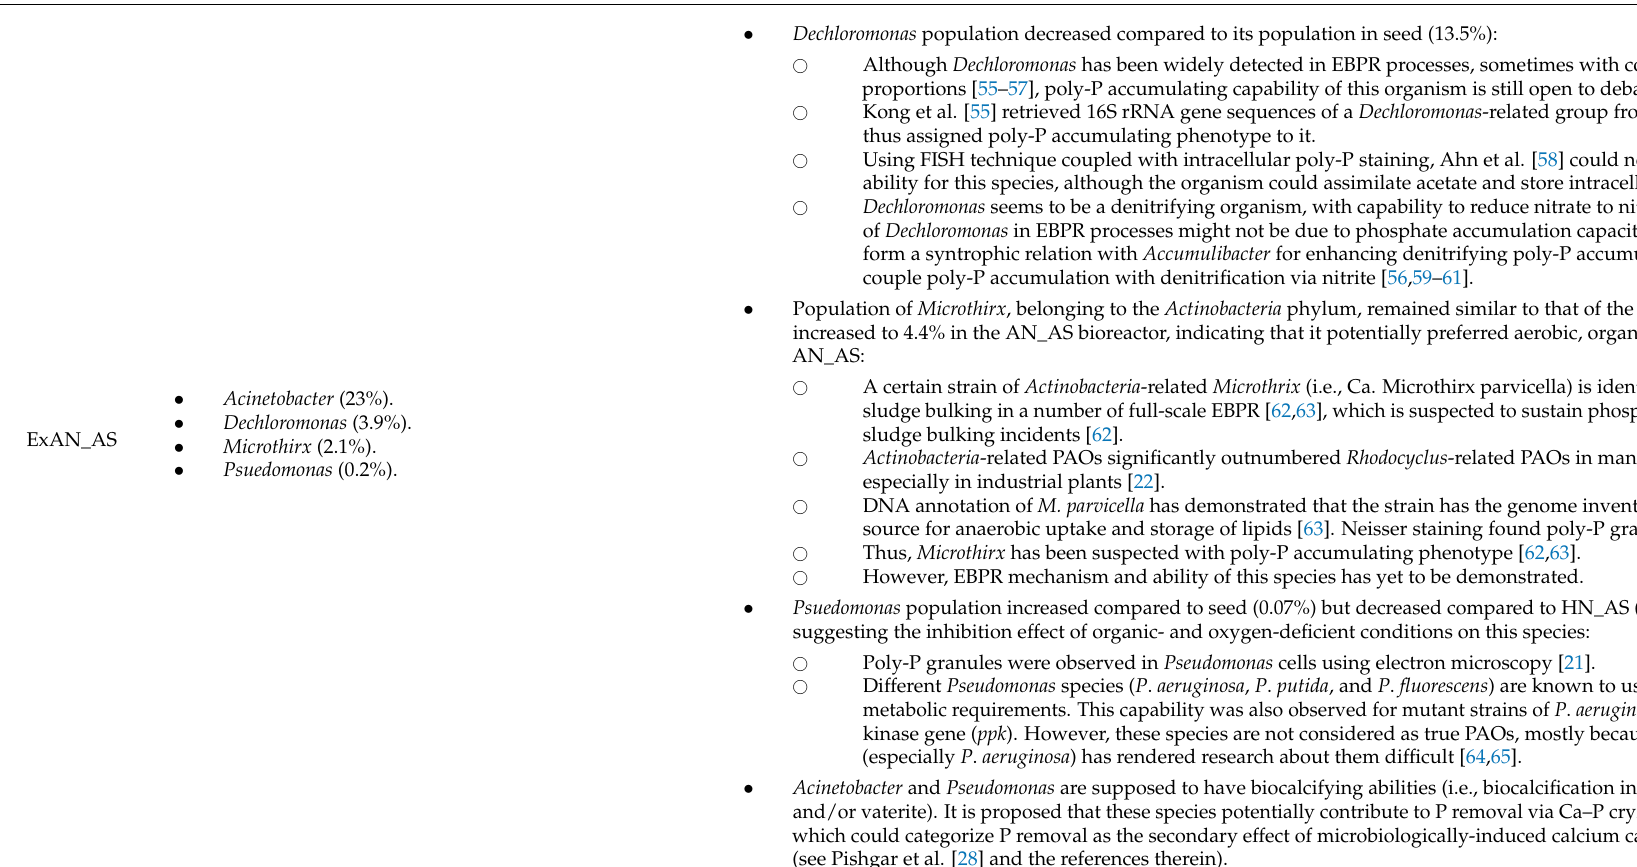
Biomass Detected